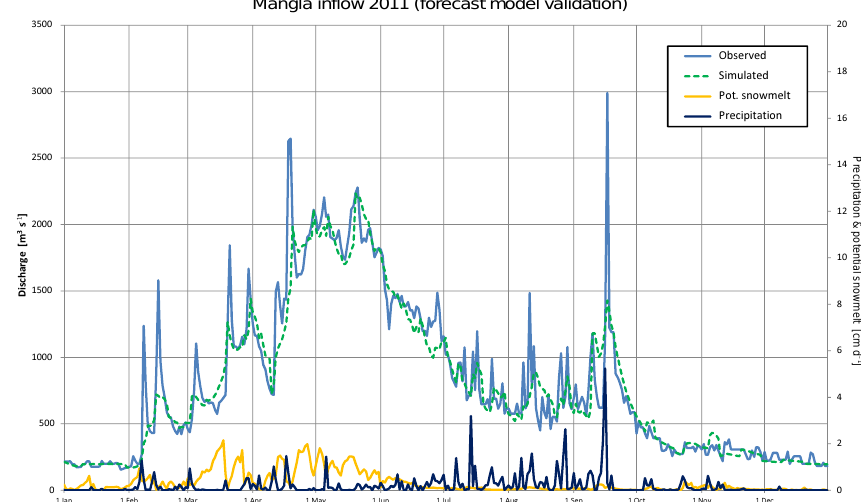
Figure 4. Results of validation of final flow forecast model (dashed line) compared to observed inflows to Mangla reservoir (solid line) for the year 2011. The graph also shows at the bottom rainfall and snowmelt depth [cmd − 1 ].